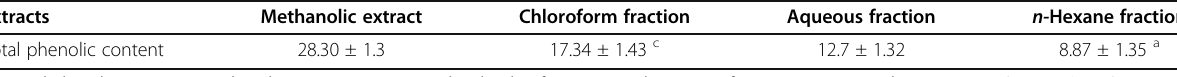
Table 3 Total phenolic content (mg GAE/g) of methanolic extract and its different fractions Extracts